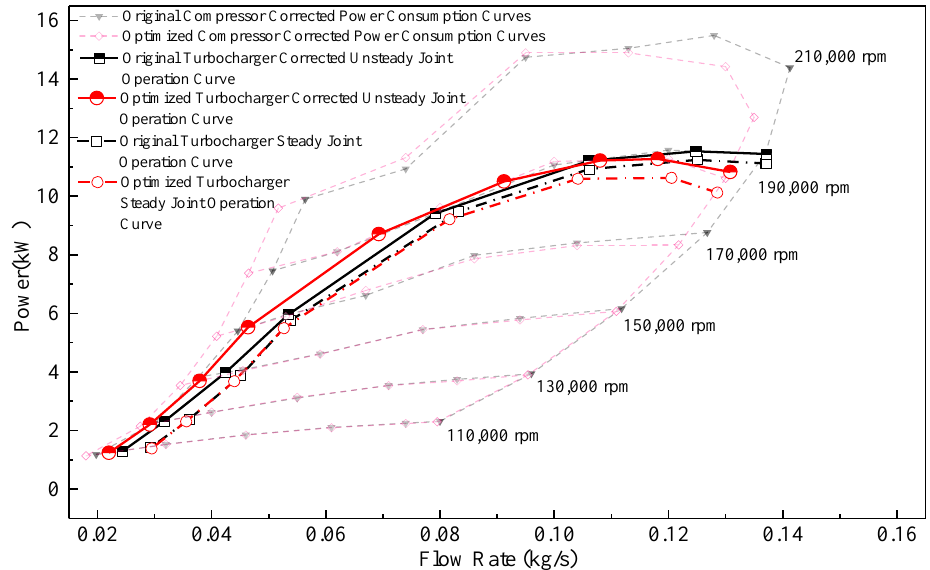
Figure 14. Comparison of the corrected curves of two turbochargers.